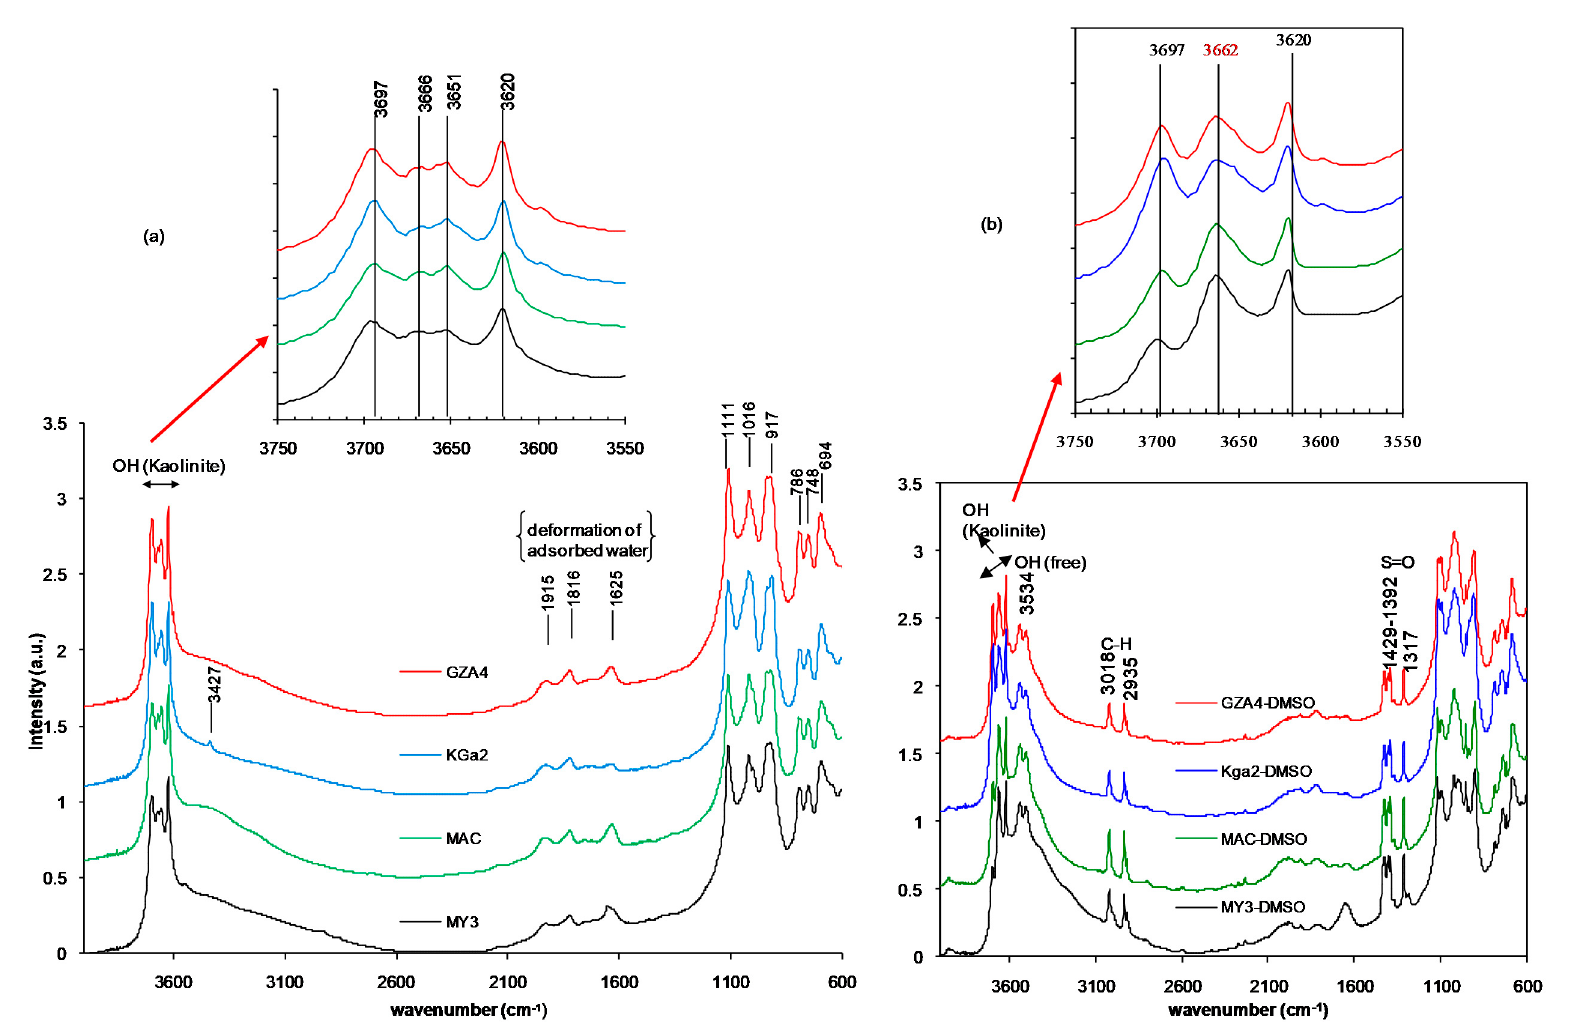
Figure 3. FTIR spectra of ( a ) the raw and ( b ) the DMSO-intercalated kaolinite samples.